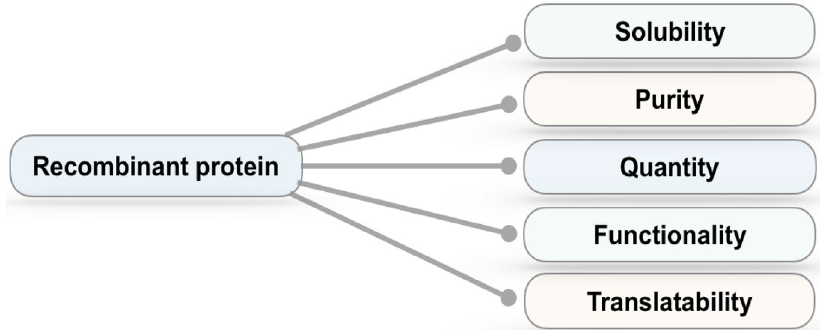
Figure 1. Recombinant protein